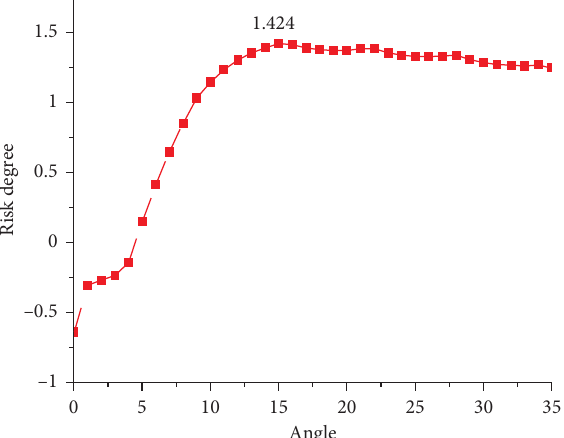
Figure 23: The hazard curve of ship collision avoidance described in this